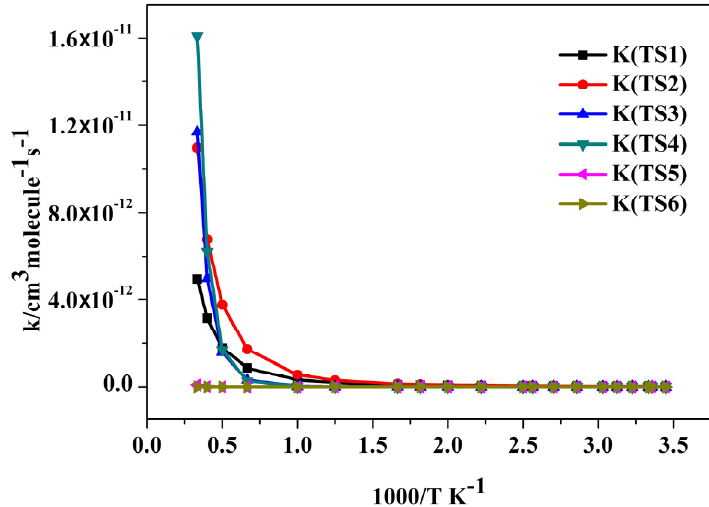
Figure 3. Theoretical rate constants for the reactions of trans-CF radical over the temperature range of 290–3,000